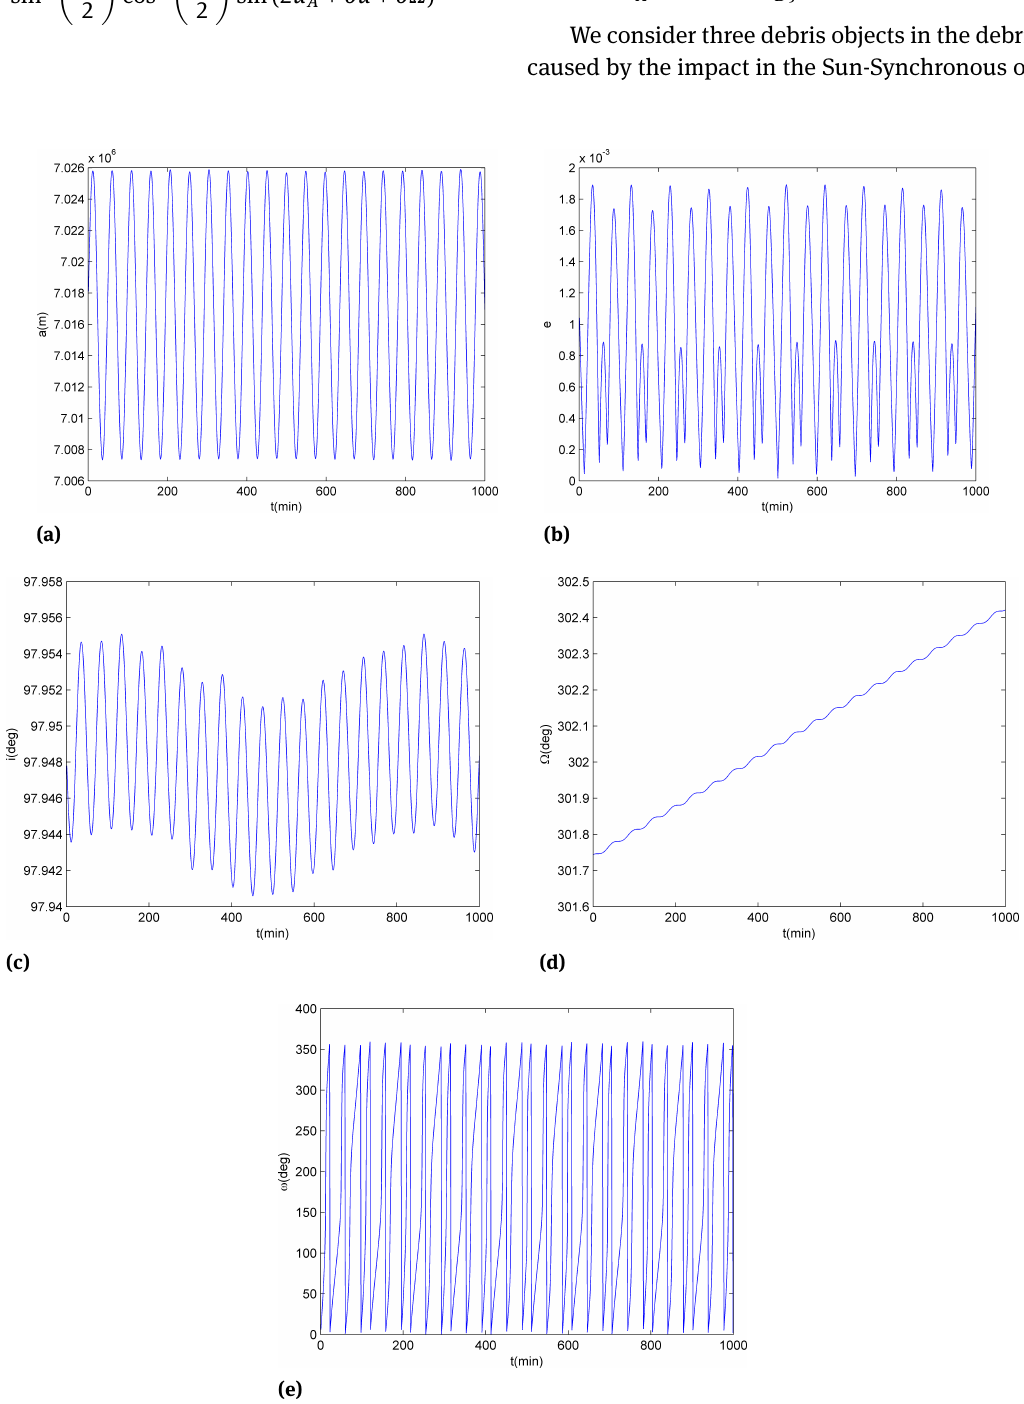
Figure 2. The orbital elements of object A in 1000 minutes.(a) semi-major axis; (b) eccentricity; (c) inclination; (d) right ascension of the ascending node; (e) Arg.